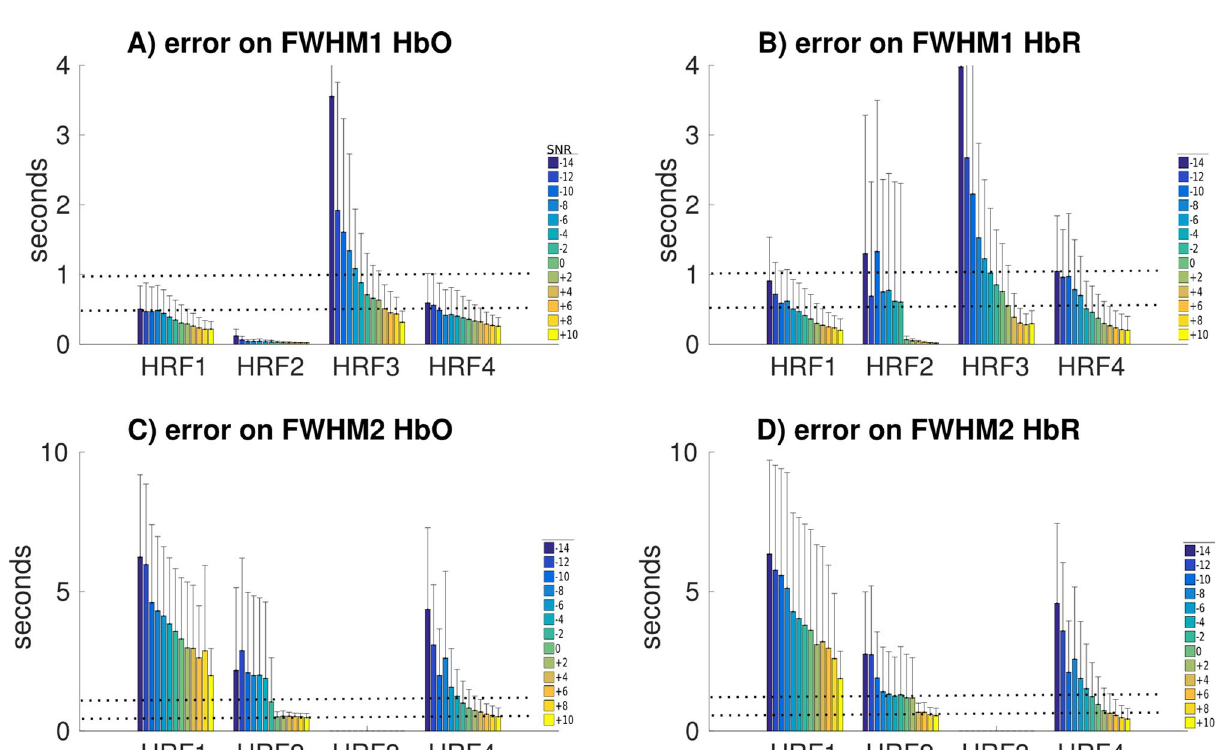
Figure 8. Distributions of the errors in the estimation of FWHM as a function of the SNR level for all HRF models. Note that FWHM2 for HRF3 was not estimated as no undershoot were